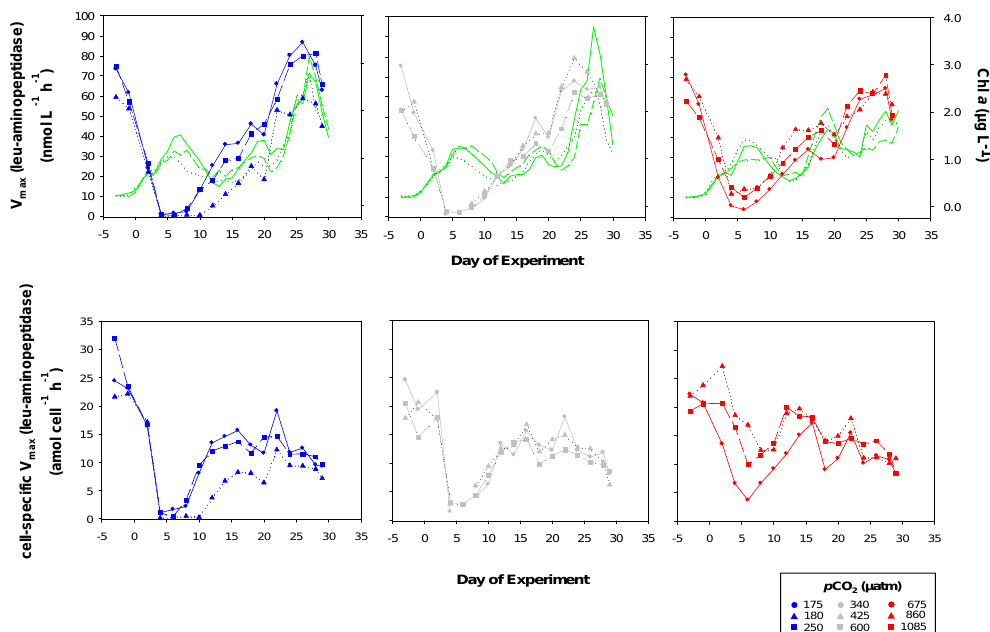
Fig. 5. Temporal development of extracellular leucine (leu)-aminopeptidase activity in mesocosms of low (175–250µatm; blue symbols), medium (340–600µatm; grey symbols), and high p CO 2 (675–1085µatm; red symbols). Maximum reaction velocities ( V max ) are normalised to volume (nmolL − 1 h − 1 ; upper panel) and bacterial abundance (amolcell − 1 h − 1 ; lower panel). Green lines represent chlorophyll a (Chl a) concentrations in the